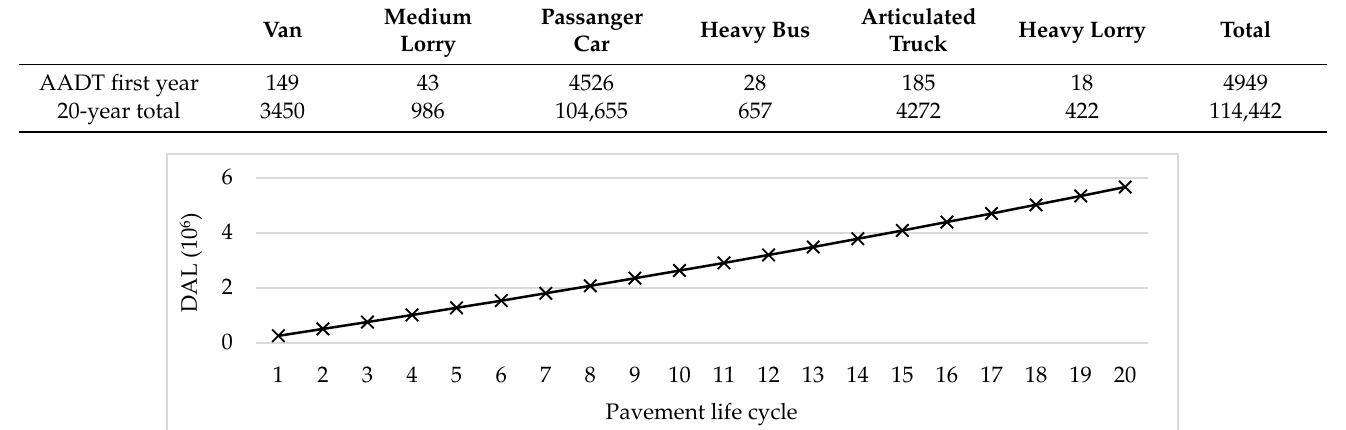
Figure 6. Pavement performance and life cycle analysis.